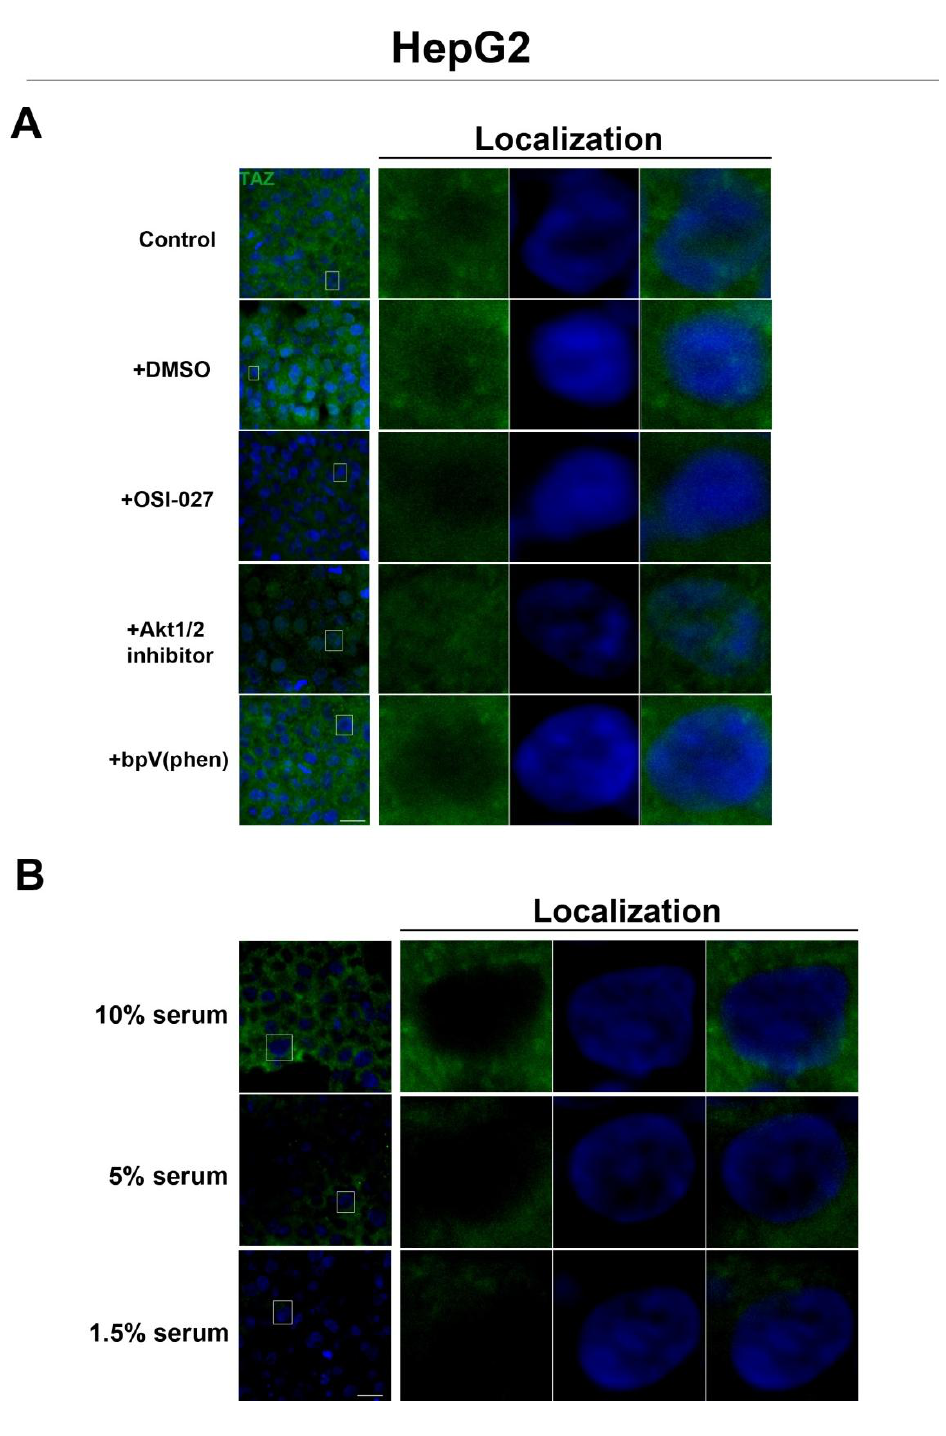
Figure 6. Akt pathway inhibition and changes in serum levels affects expression and localization of TAZ in HepG2 cells. (A) Decreased levels of TAZ (green) were observed at high cell density conditions after treatment with an Akt inhibitor but not with the PTEN inhibitor bpV(phen). (B) Decreased levels of TAZ were also observed at high cell density conditions after a reduction in serum levels. Panels on the right represent boxed images on the left: localization of TAZ in high cell density conditions demonstrates mostly cytoplasmic expression that does not change upon OSI-027 treatment but shifts to the nucleus upon Akt1/2 inhibitor treatment. TOPRO3 (blue) labels nuclei. Scale bars, 20